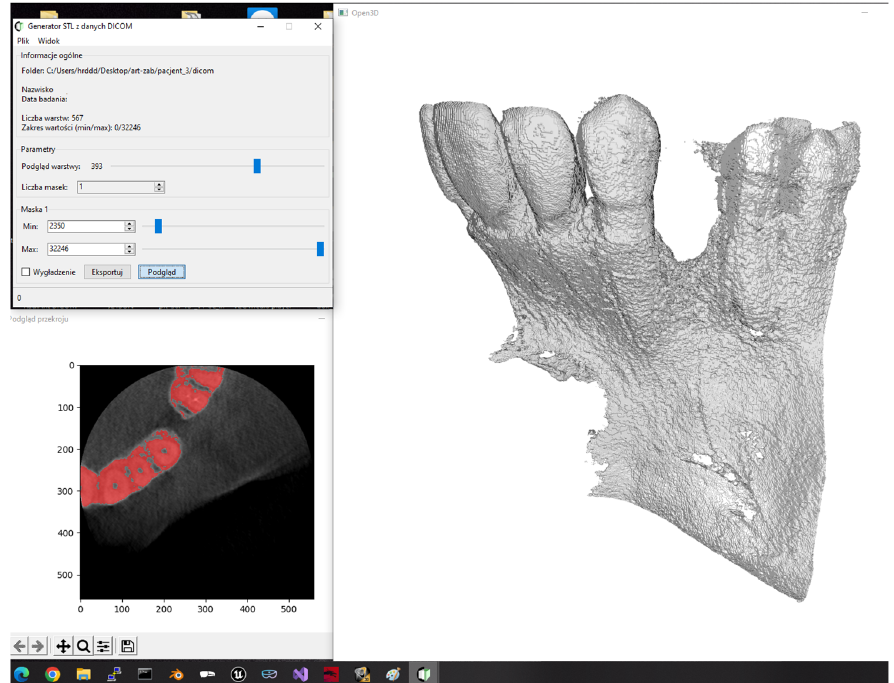
Figure 6. The screenshot of the application enables the creation of 3D holograms based on the CT scan (DICOM data).